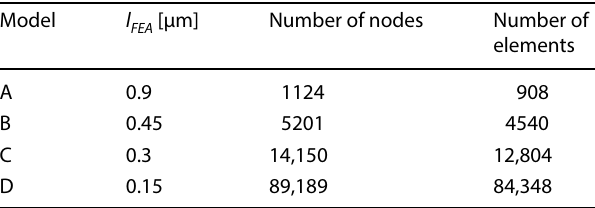
Table 2 Minimum mesh size, nodes, and elements in each finite element model Model